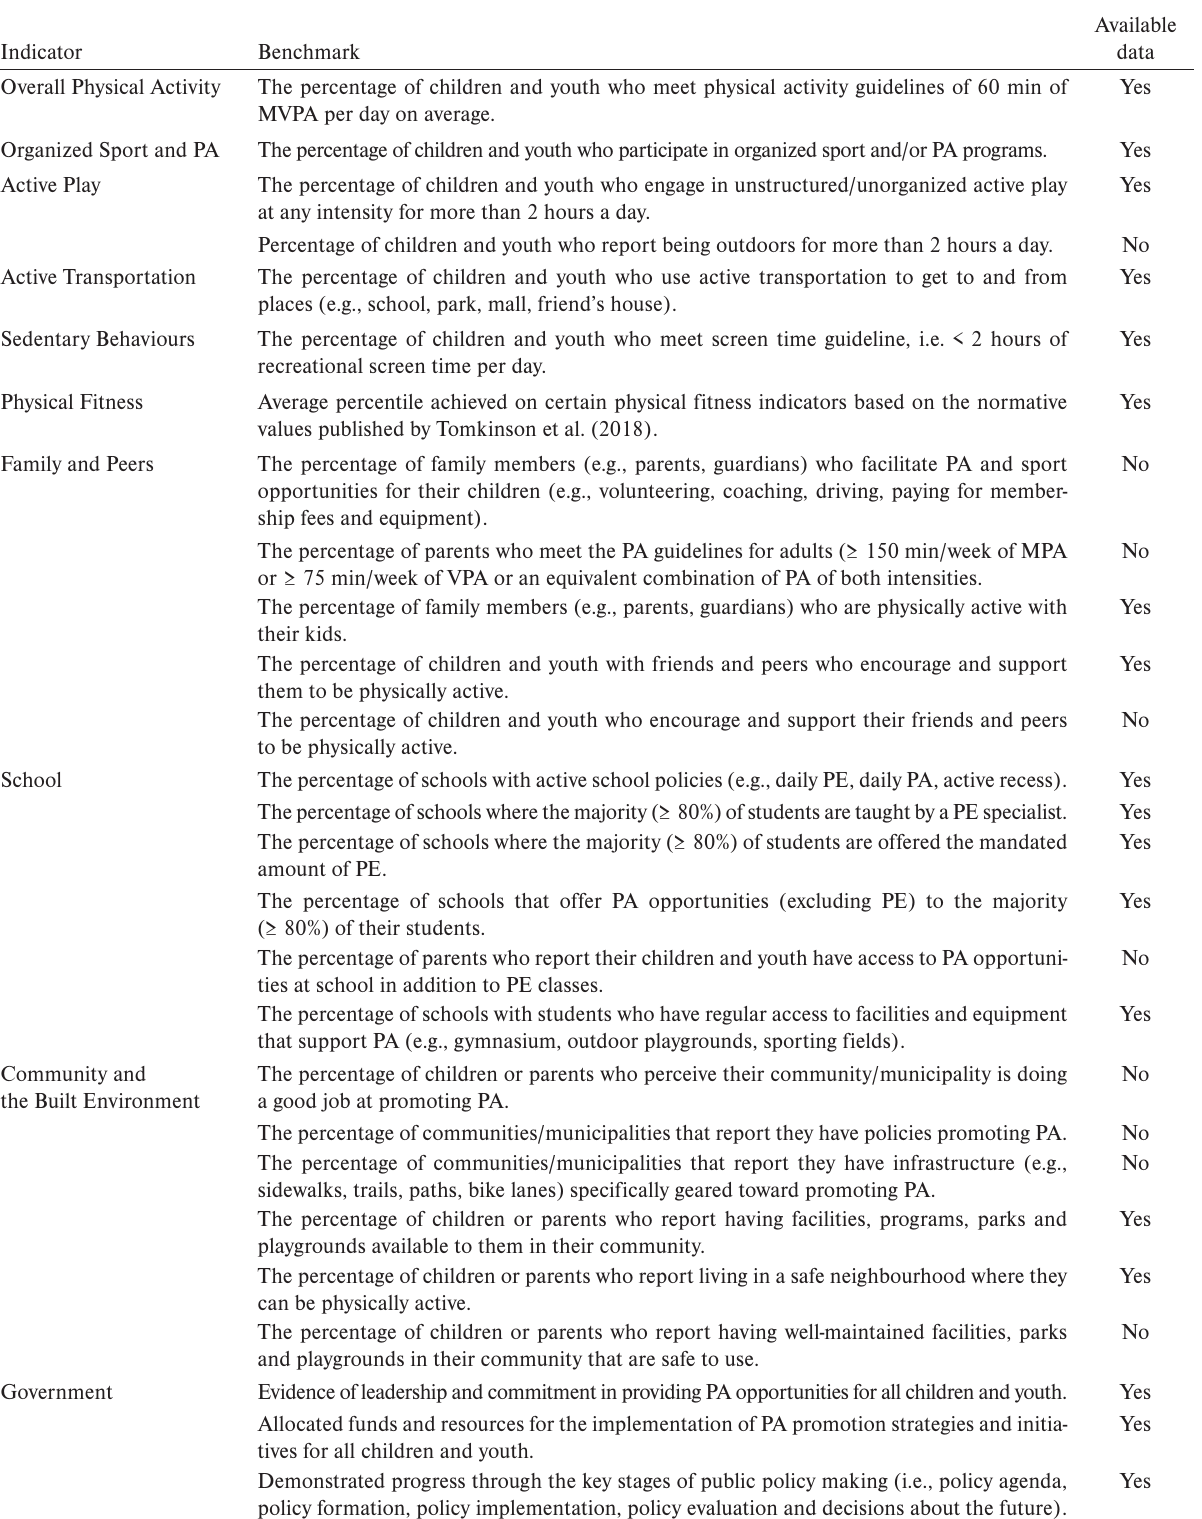
Table 1 Set of indicators and benchmarks used to guide the grade assignment process